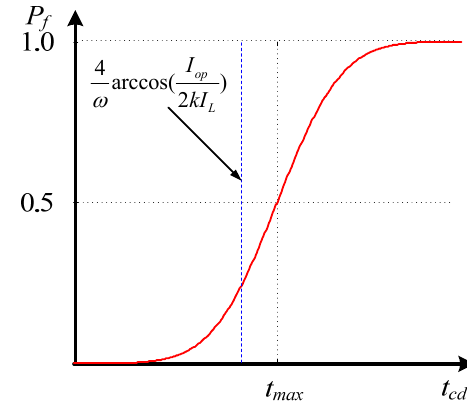
Figure 5. False trip probability follows the first form of braking ratio criterion and start